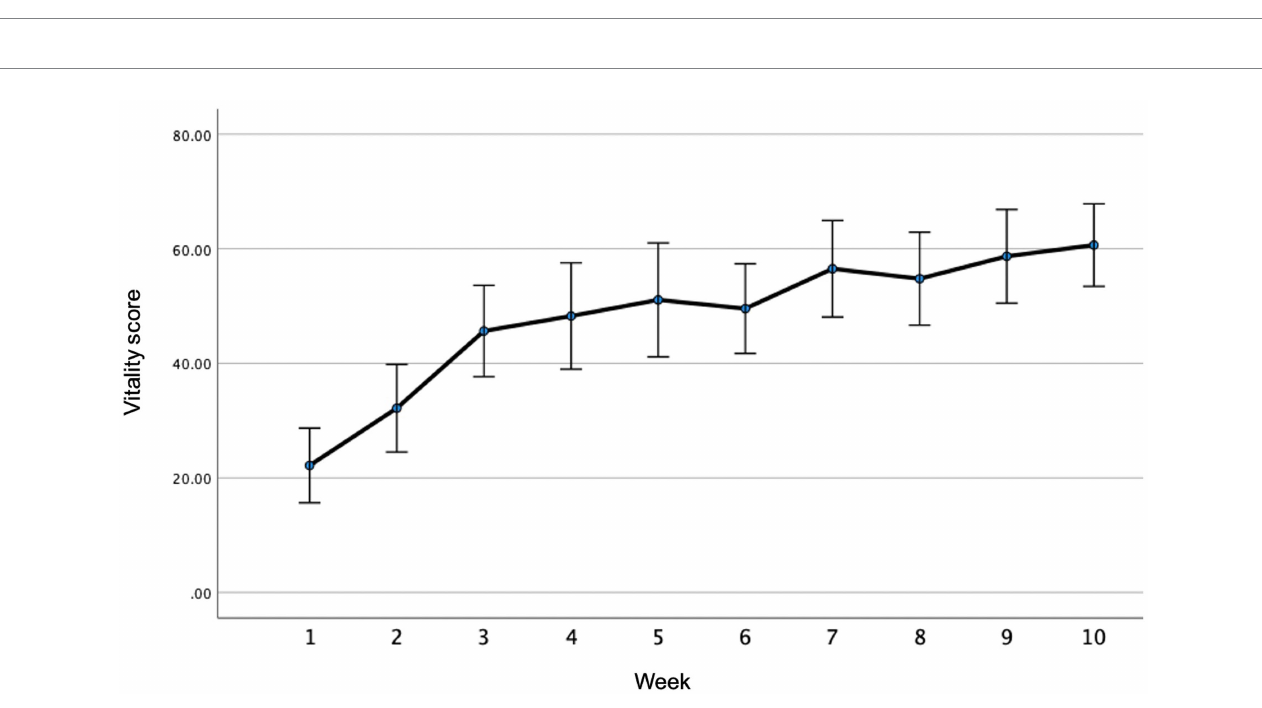
FIGURE 2 Weekly vitality/energy (VIT) scores throughtout the